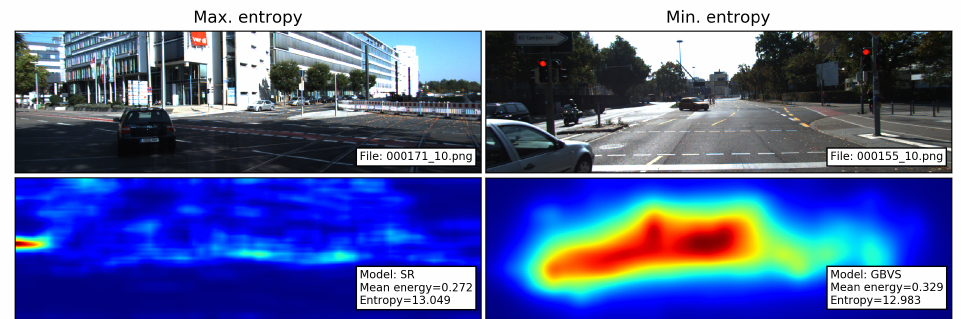
Figure 3. Images and the corresponding saliency maps with the maximum and minimum entropy. SR produces complex areas of saliency (cf. SR saliency map in Figure 2). In contrast, the higher saliency values produced by the GBVS model appear to be concentrated in a single